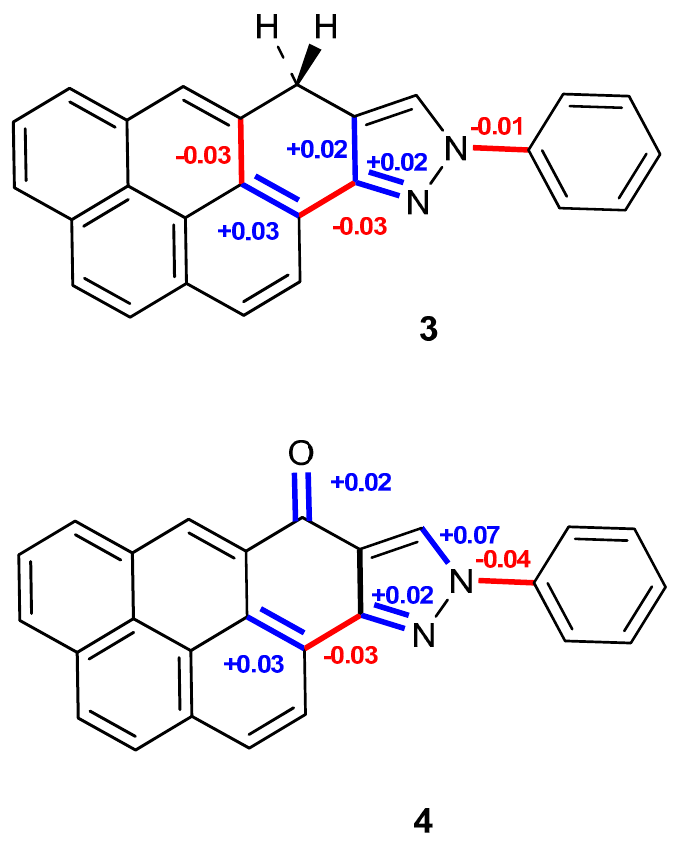
Figure 8. Significant bond length changes in 3 and 4 upon S 0 → S 1 excitation. Contracted bonds are represented in red and elongated bonds in blue. Bond length changes are expressed in Å.